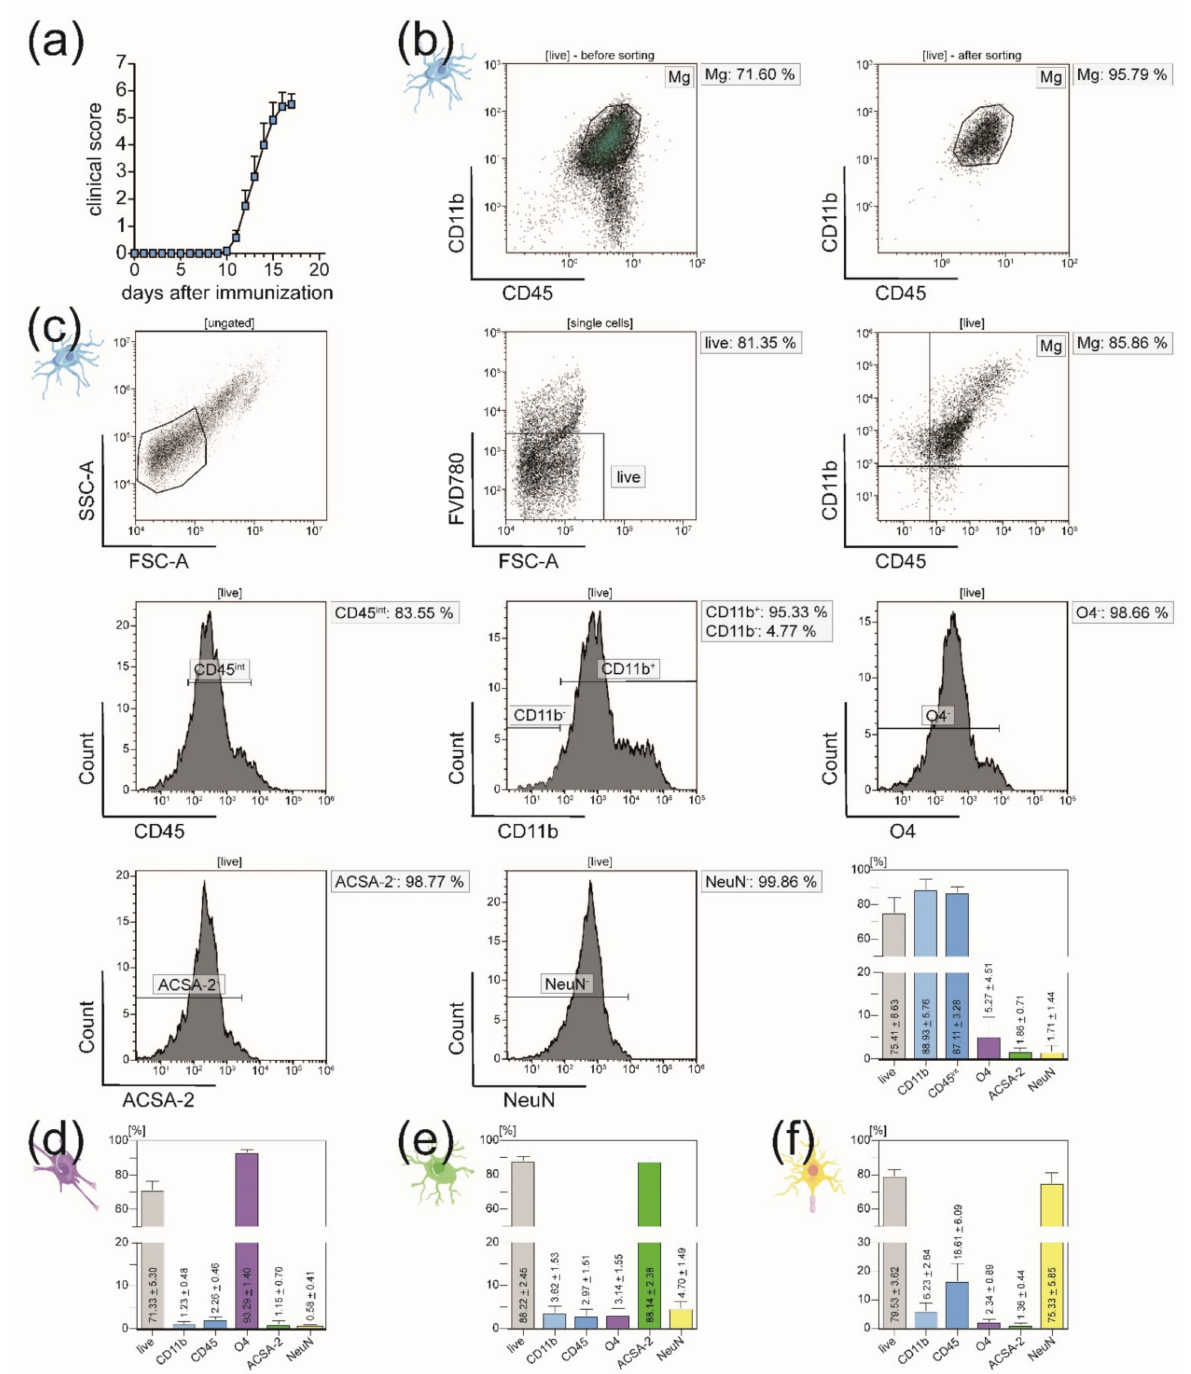
Figure 7. Flow cytometry analyses of CNS-resident cells isolated from adult EAE mice. ( a ) Clinical course of EAE mice (group size = 12 mice). Error bars show mean ± SEM. ( b ) Purity of isolated microglia measured with BD FACSAria III before and after sorting of CD45 int CD11b high cells from CD11b + single-cell suspension. Via FACS, purity was increased from 71.60% to 95.79%. ( c ) Representative purity analysis of sorted CD45 int CD11b high cell fraction with flow cytometry purity panel used for all four major CNS-resident cell types. The bar graph illustrates the percentage of viable target cells within the resulting single-cell suspension ( n = 4). Means ± SEMs are indicated in the bar graphs. ( d – f ) Bar diagrams summing up the viability and purity after isolation of oligodendrocytes ( d ; n = 6), astrocytes ( e ; n = 6), and neurons ( f ; n = 5) from adult EAE mice applying the same MACS protocol used for naïve mice . Means ± SEMs are depicted in the bar